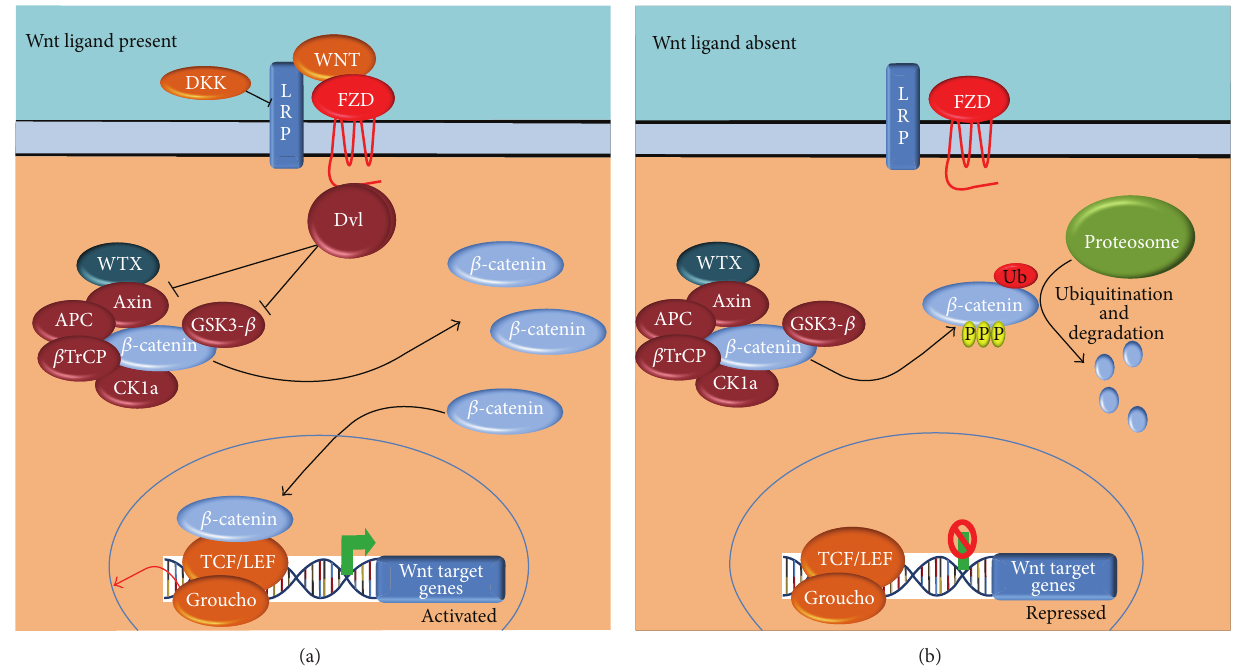
Figure 1: The canonical Wnt signalling pathway implicated in diabetic nephropathy. When a WNT ligand binds to the Frizzled (FZD) and the LRP5/6 coreceptors, the Dvl protein is recruited and inhibits the binding of 𝛽 -catenin, leading to an increase in cytoplasmic 𝛽 -catenin levels and subsequent activation of downstream signalling targets (a). In the absence of any WNT ligand (b), 𝛽 -catenin is sequestered by the Axin complex containing such proteins as GSK3- 𝛽 , APC, CK1, 𝛽 TrCP, and axin itself. 𝛽 -catenin is then phosphorylated and ubiquitinated and enters the proteasomal degradation pathway and leading to subsequent repression of downstream signalling